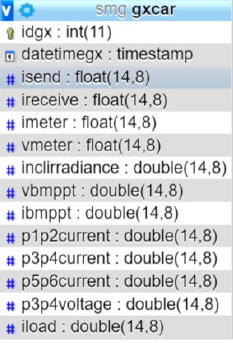
Figure 5. Database created with mariaDB for characterization of PV modules.